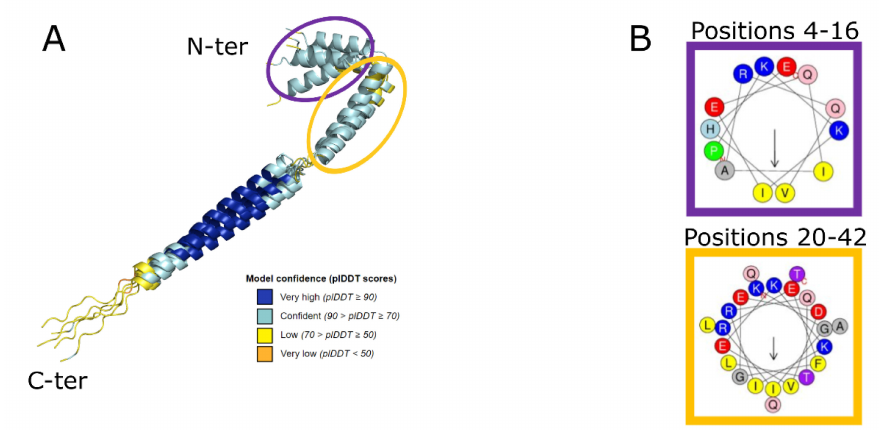
Figure 2. Modelling of UbiK monomer. ( A ) Structural alignment of 5 UbiK models predicted by AF2. Structural models were superimposed using Pymol. 3D models are displayed in cartoon coloured as a function of plDDT value. ( B ) Prediction of amphipathic helix profiles using HeliQuest server [26]. Hydrophobic and polar residues correspond to yellow and red/blue circles, respectively. Residue numbering corresponds to the Uniprot sequence (Uniprot ID: